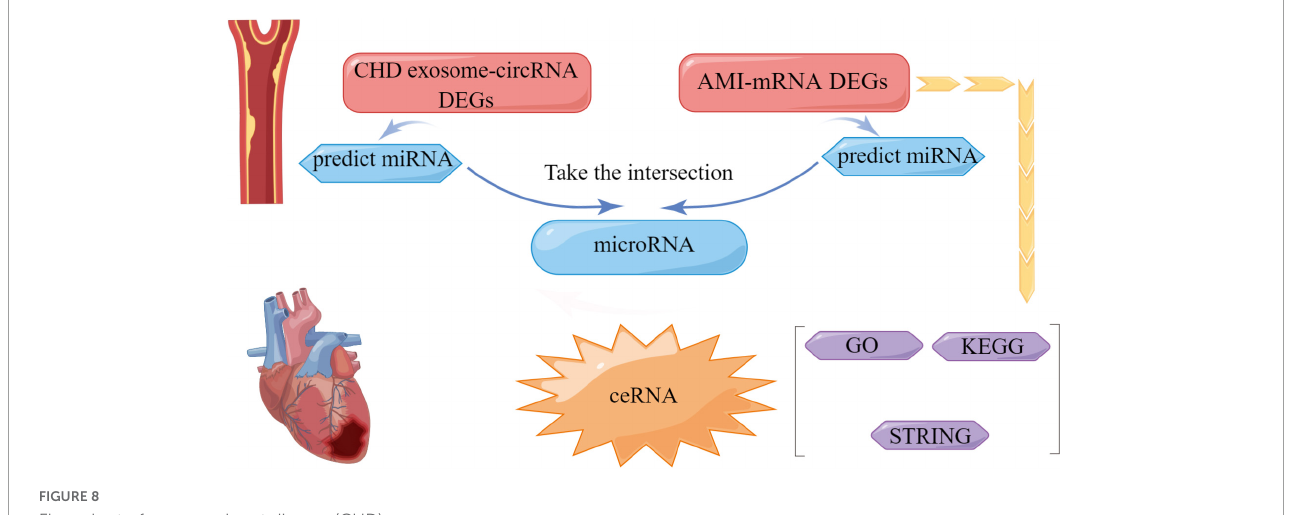
FIGURE8 Flow chart of coronary heart disease